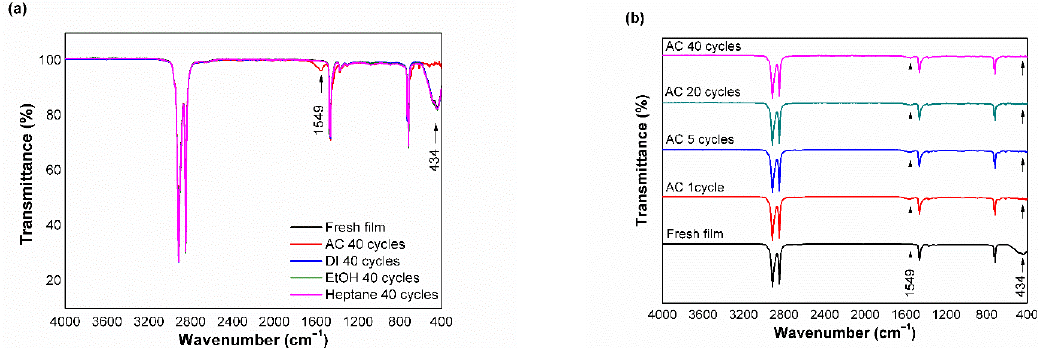
Figure 1. FTIR spectra of ( a ) fresh film and films treated with DI water, EtOH, AC, and heptane after 40 cycles; ( b ) films treated with AC after different number of cycles.